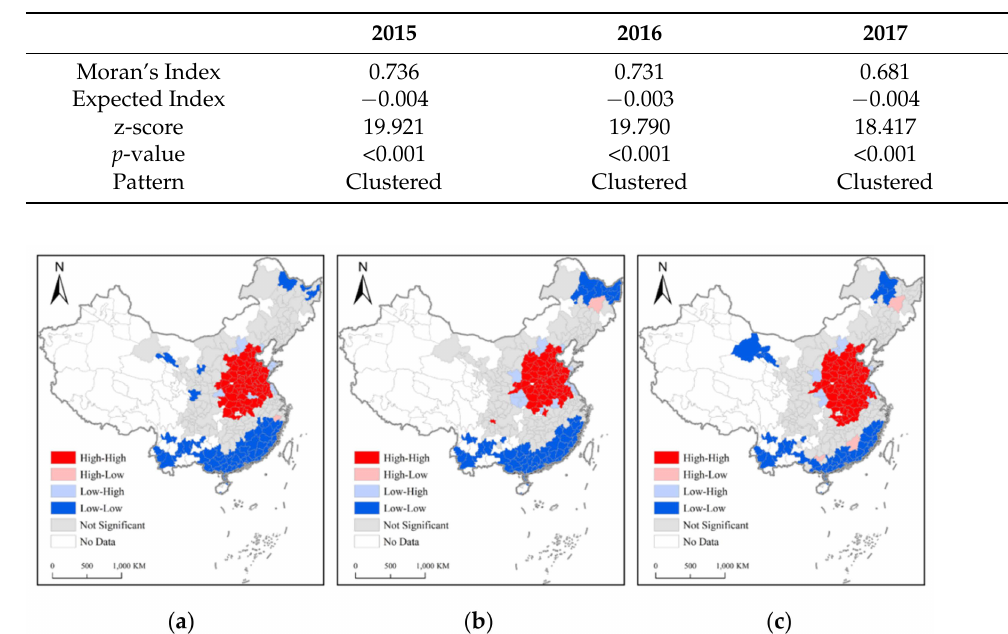
Figure 3. Local Moran’s I clusters of PM2.5: ( a ) 2015; ( b ) 2016; ( c )